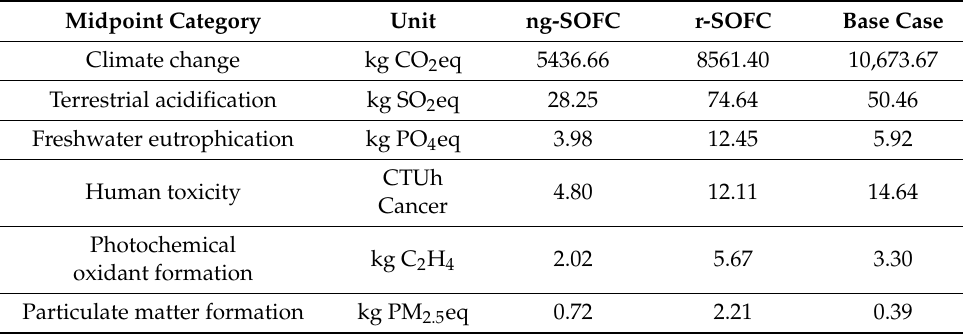
Table 7. LCA scores calculated with ReCiPe 2008 Midpoint